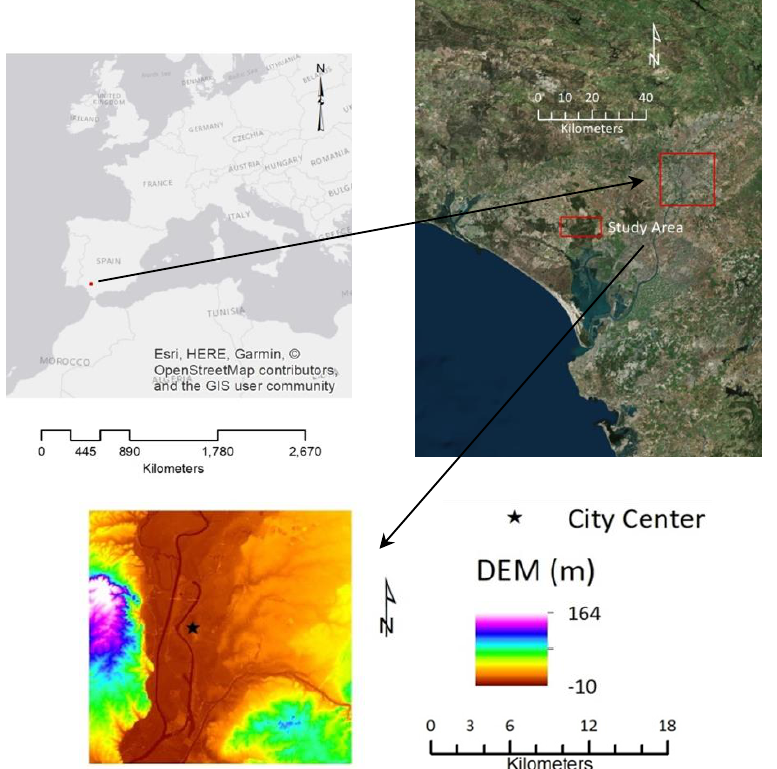
Figure 1. Location and Digital Elevation Model of the study area: Seville City, Spain. The largest of the two red squares represents the study area, this area coincides with the area analyzed with the satellite images. The second red box represents the legend, which defines that the first red box is the study area.